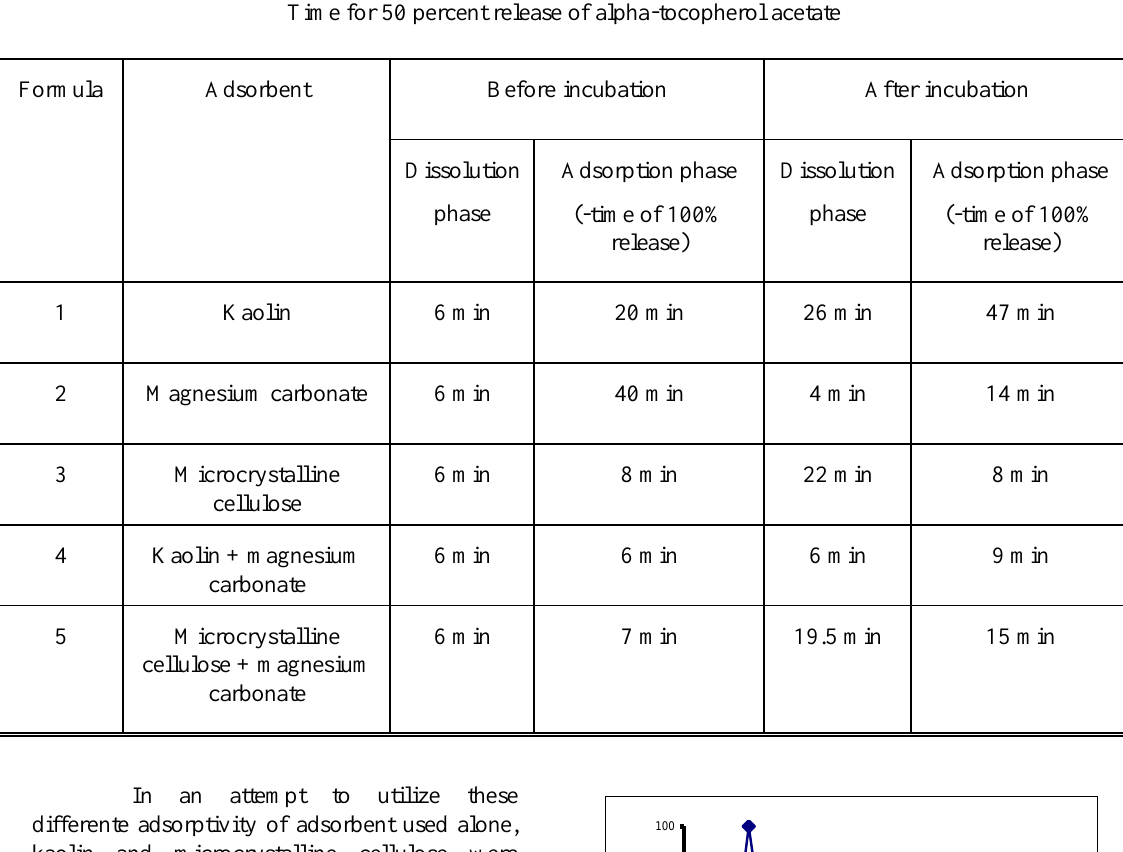
Table 2: The time of 50% release of alpha-tocopherol acetate at two phases for different formula before and after incubation period.